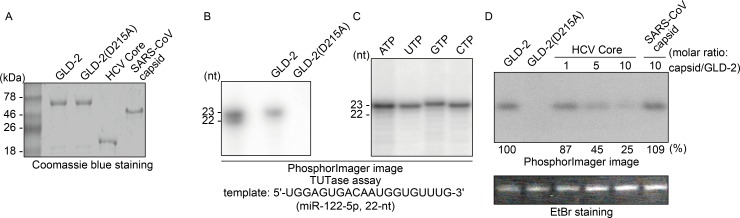
Inhibition of GLD-2 by the HCV core protein.(A) Coomassie blue staining of purified recombinant proteins used in terminal transferase assays. (B and C) A terminal transferase assay with miR-122-5p (22-nt long guide-strand RNA) and GLD-2 or its inactive form GLD-2(D215A) in the presence of [α-32P]ATP (B) or each of the indicated radiolabeled ribonucleotides (C). Radiolabeled RNA products were resolved by PAGE on a denaturing polyacrylamide gel (15%) and visualized using a PhosphorImager. As size markers, 5′-32P-labeled miR-122 isomers were used. (D) Inhibition of GLD-2 3′ adenylation activity by the HCV core protein. The amount of the HCV core protein or SARS-CoV capsid protein added to the reactions is shown as a molar ratio to GLD-2. The radioactivity present in the bands was quantified using a PhosphorImager and expressed as a percentage compared with the GLD-2 alone control. Shown below the autoradiogram is ethidium bromide (EtBr) staining of the gel showing the amounts of miR-122 template used in the assays.